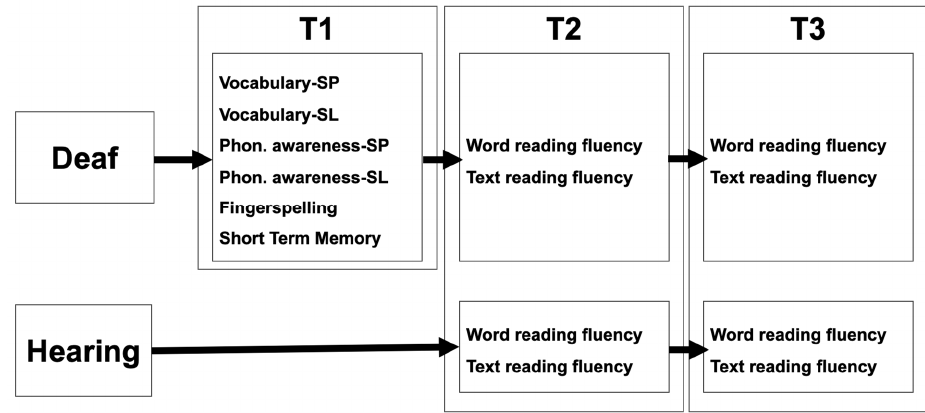
Figure 1. Detailed testing schedule across the years for deaf and hearing